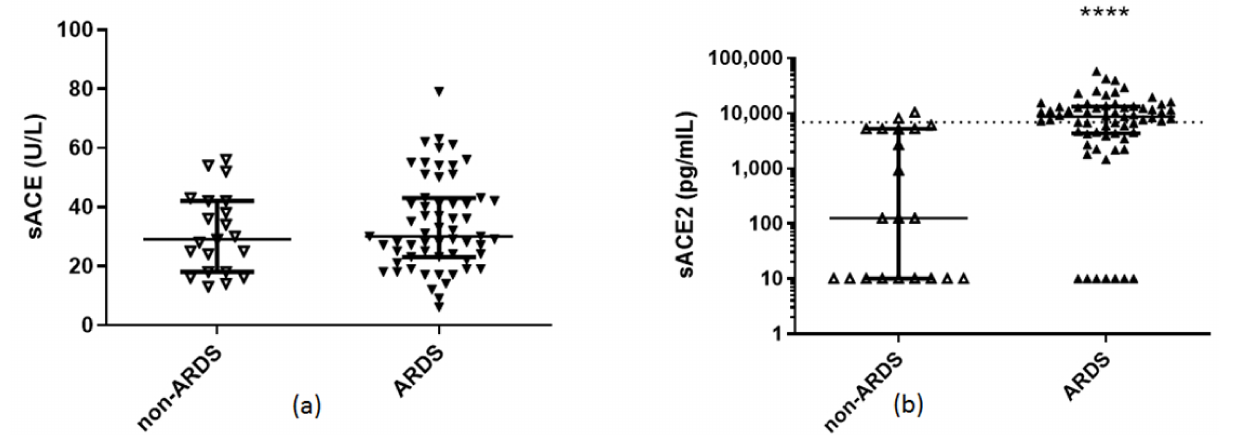
Figure 2. Hospital admission levels of serum ACE activity and soluble ACE2 in COVID-19 patients. ( a ) Serum ACE activity, and ( b ) soluble ACE2 were measured in 21 COVID-19 non-ARDS patients and 68 patients with COVID-19-inflicted ARDS on hospital admission (within 24 h). Two-group comparisons were performed with the non-parametric Mann–Whitney test, **** p < 0.0001. Data are presented as scatter plots, indicating the median value and 25th to 75th centiles. Dashed line, median value of the whole cohort. ARDS = acute respiratory distress syndrome; sACE = serum angiotensin converting enzyme; sACE2 = soluble angiotensin converting enzyme